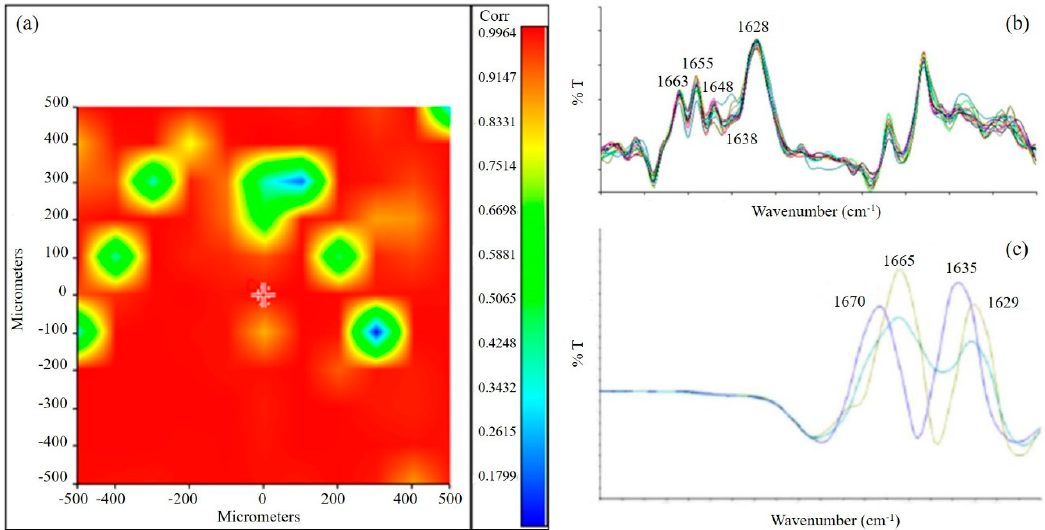
Figure 4. ( a ) Correlation map between the chemical map and the medium spectrum. The green areas in the correlation map are the pores of the sponge; ( b ) Second derivative of AGE spectrum; ( c ) Second derivative of gelatin spectrum.